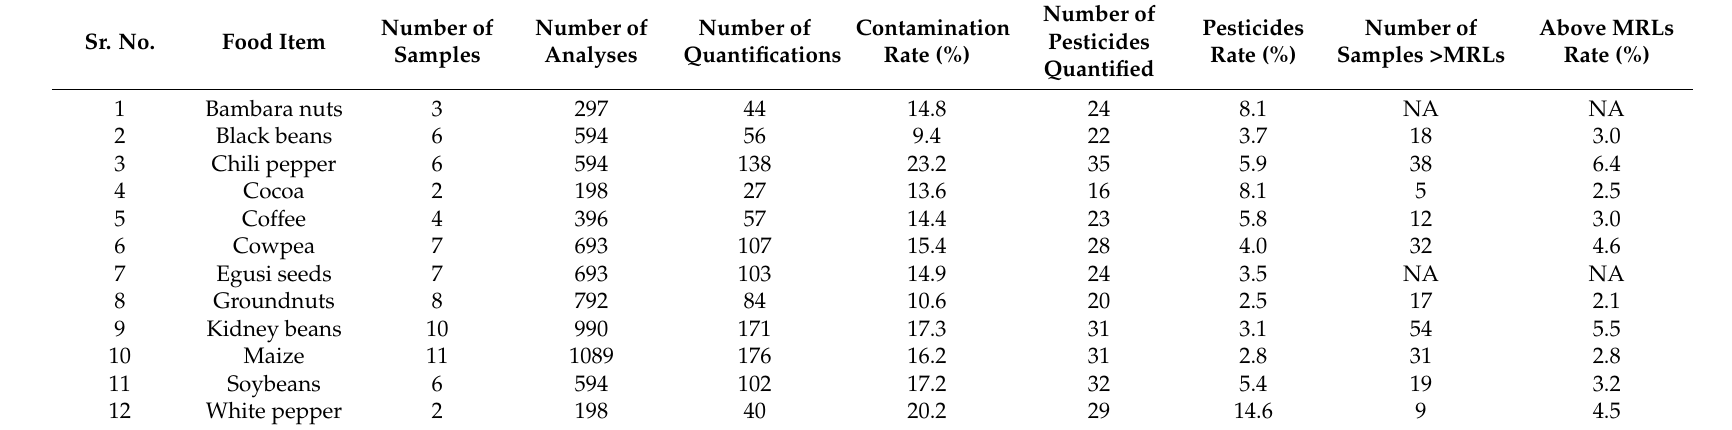
Table 4. Distribution of quantified pesticides in the 12 food items from the western highlands of Cameroon.